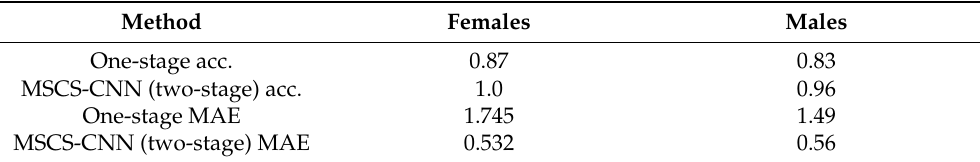
Table 5. Comparison of one- and two-stage classification performance. Method Females Males One-stage